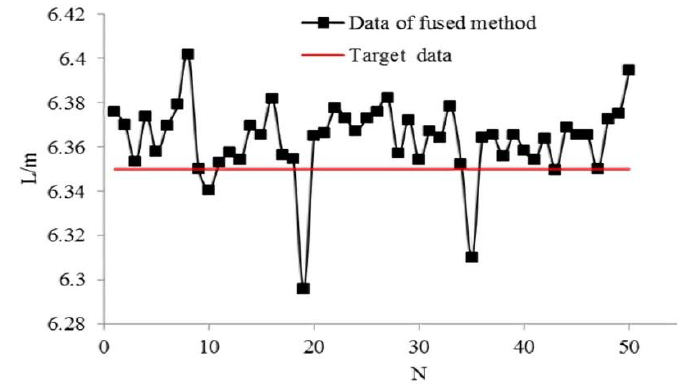
Figure 17. Results of multi-sensor information ensemble. Table 4. Comparison results on parking space recognition.